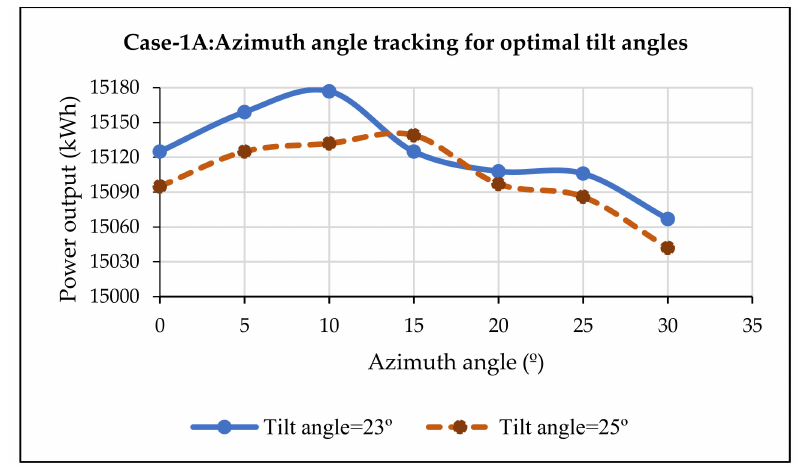
Figure 12. The power output system for distinct azimuth angles.